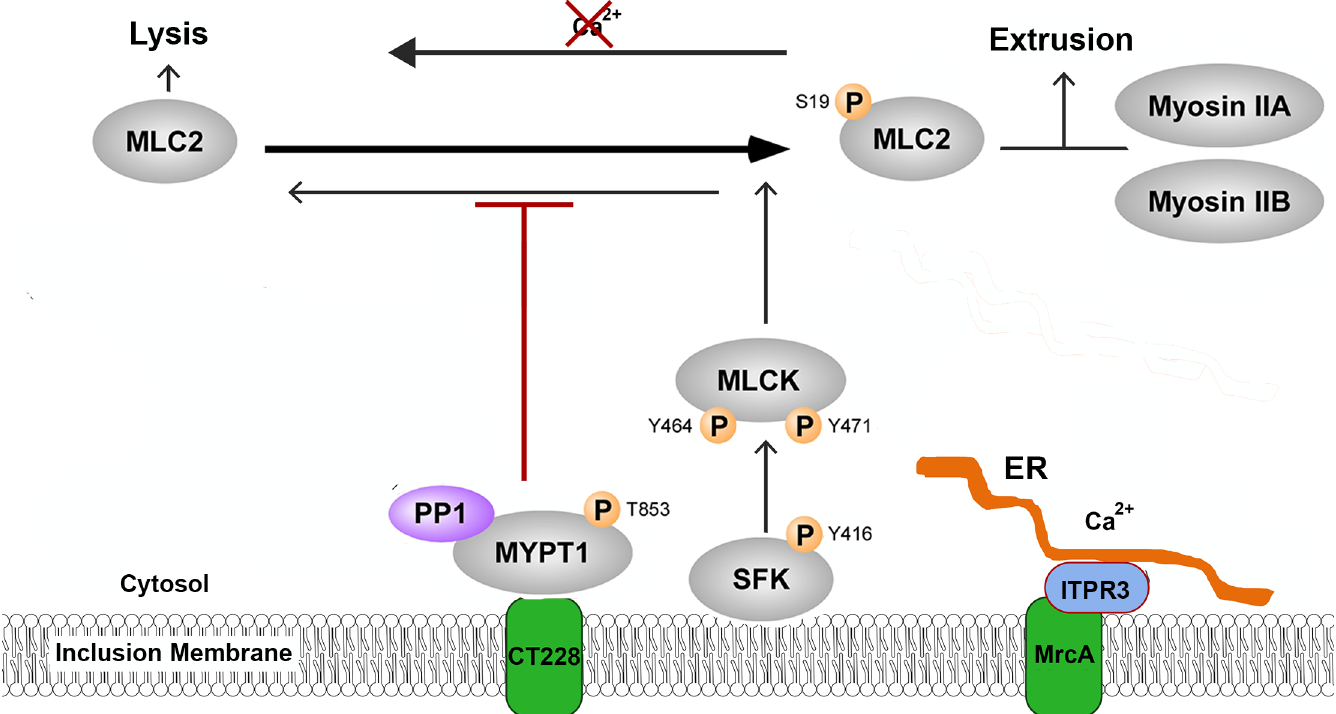
Fig 8. Schematic representation of myosin complex pathway in C . trachomatis microdomains. The myosin phosphatase pathway in C . trachomatis microdomains as described [20]. The phosphorylation state of MLC2 regulating the balance of exit by lysis and extrusion, is determined by kinase activity of MLCK and phosphatase activity of MYPT1. Through interaction with MrcA, ITPR3 is recruited to inclusion-ER contact sites or microdomains where it is expected to modulate local Ca 2+ concentrations which influence the relative activities of both myosin kinase and myosin phosphatase to promote extrusion.